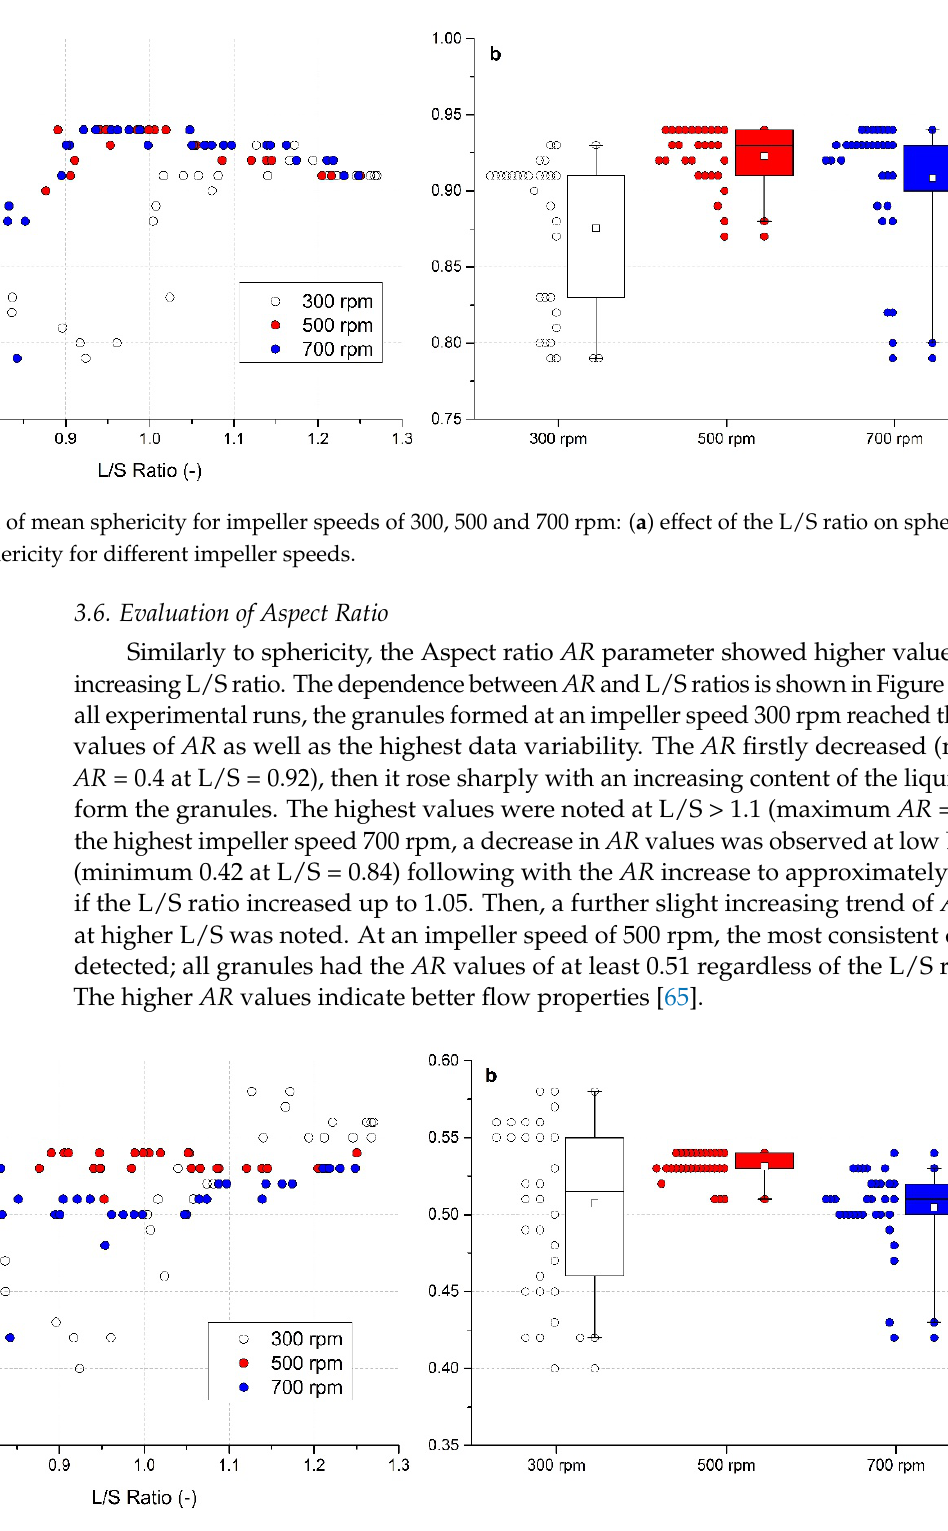
Figure 7. Evaluation of the aspect ratio for impeller speeds of 300, 500, and 700 rpm: ( a ) effect of the L/S ratio on aspect ratio, ( b ) box charts of aspect ratio for different impeller speeds.